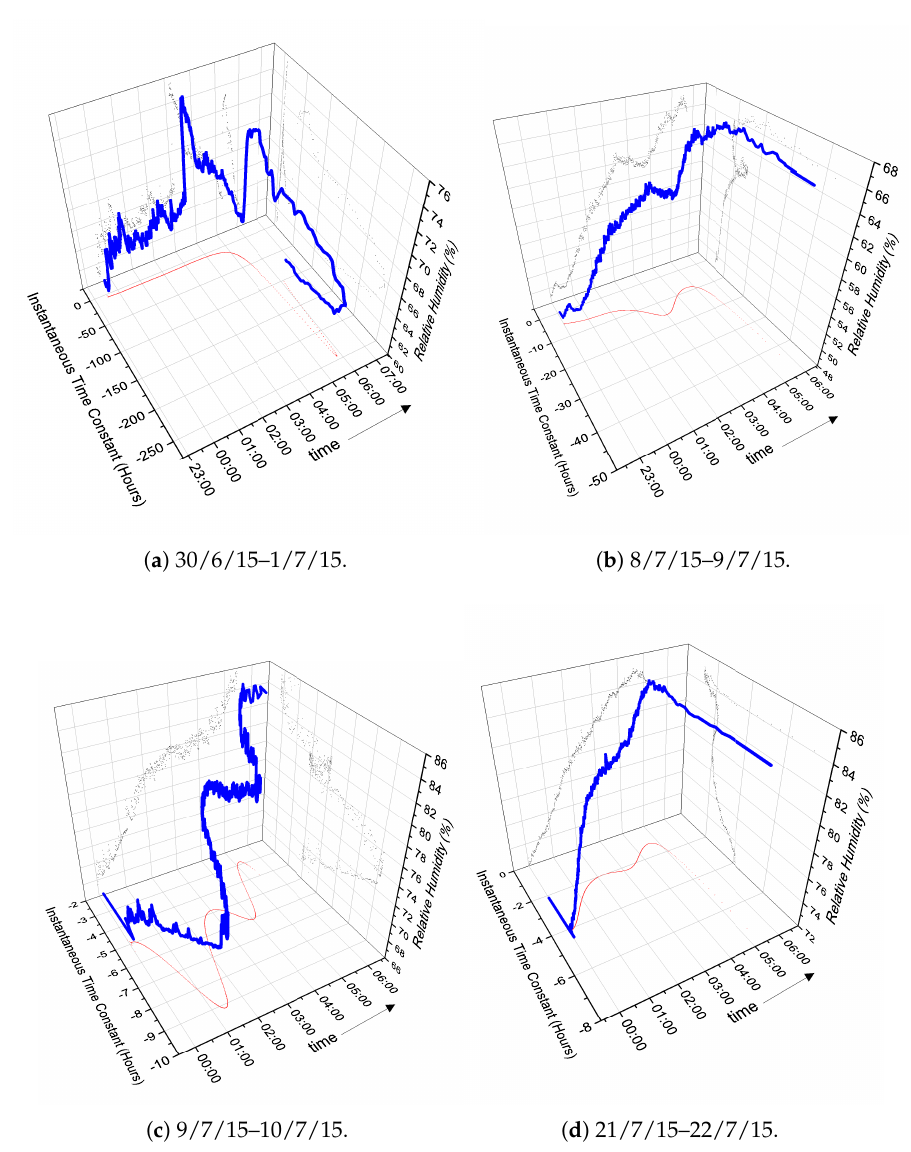
Figure 12. Relative Humidity plotted against instantaneous time constant and time for the first 4 overnight